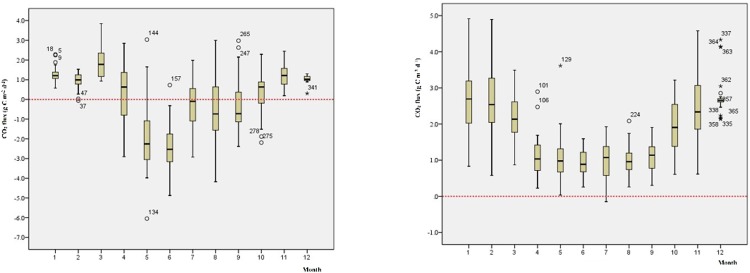
Monthly variations of the CO2 flux at 5R (a) and DB (b).